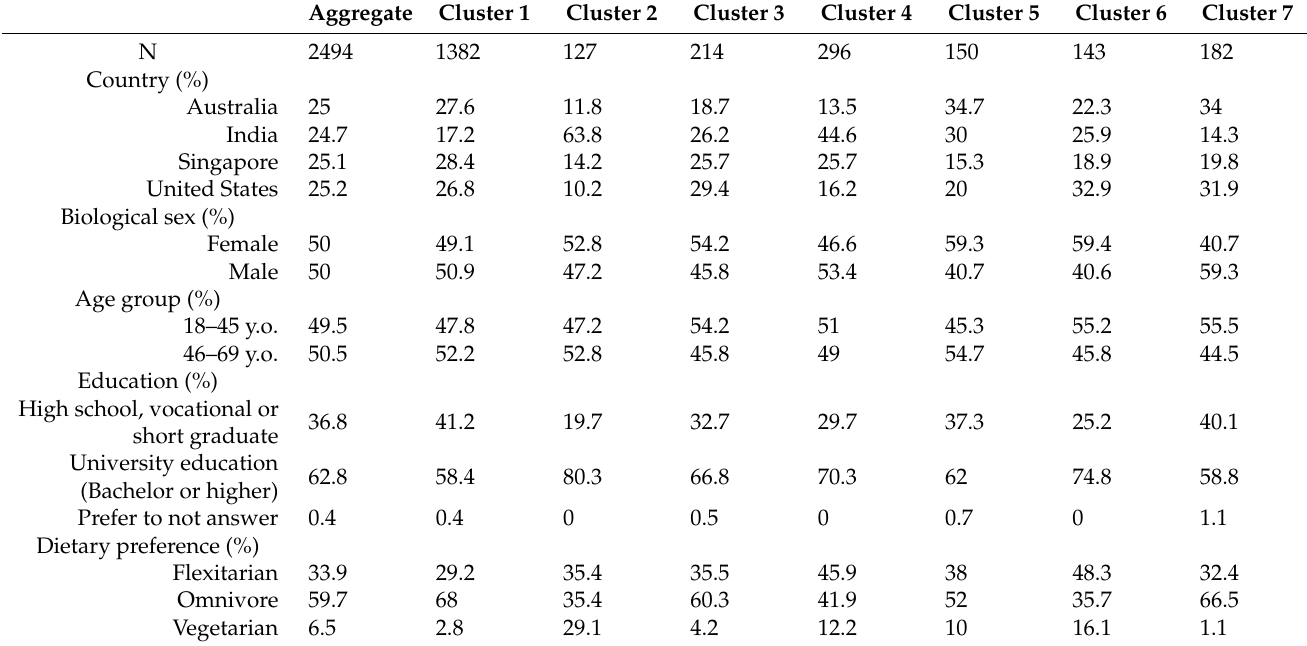
Table 1. Participant characteristics for aggregate sample and by consumer segments based on willingness to consume (WTC) for plant-based (PB) food